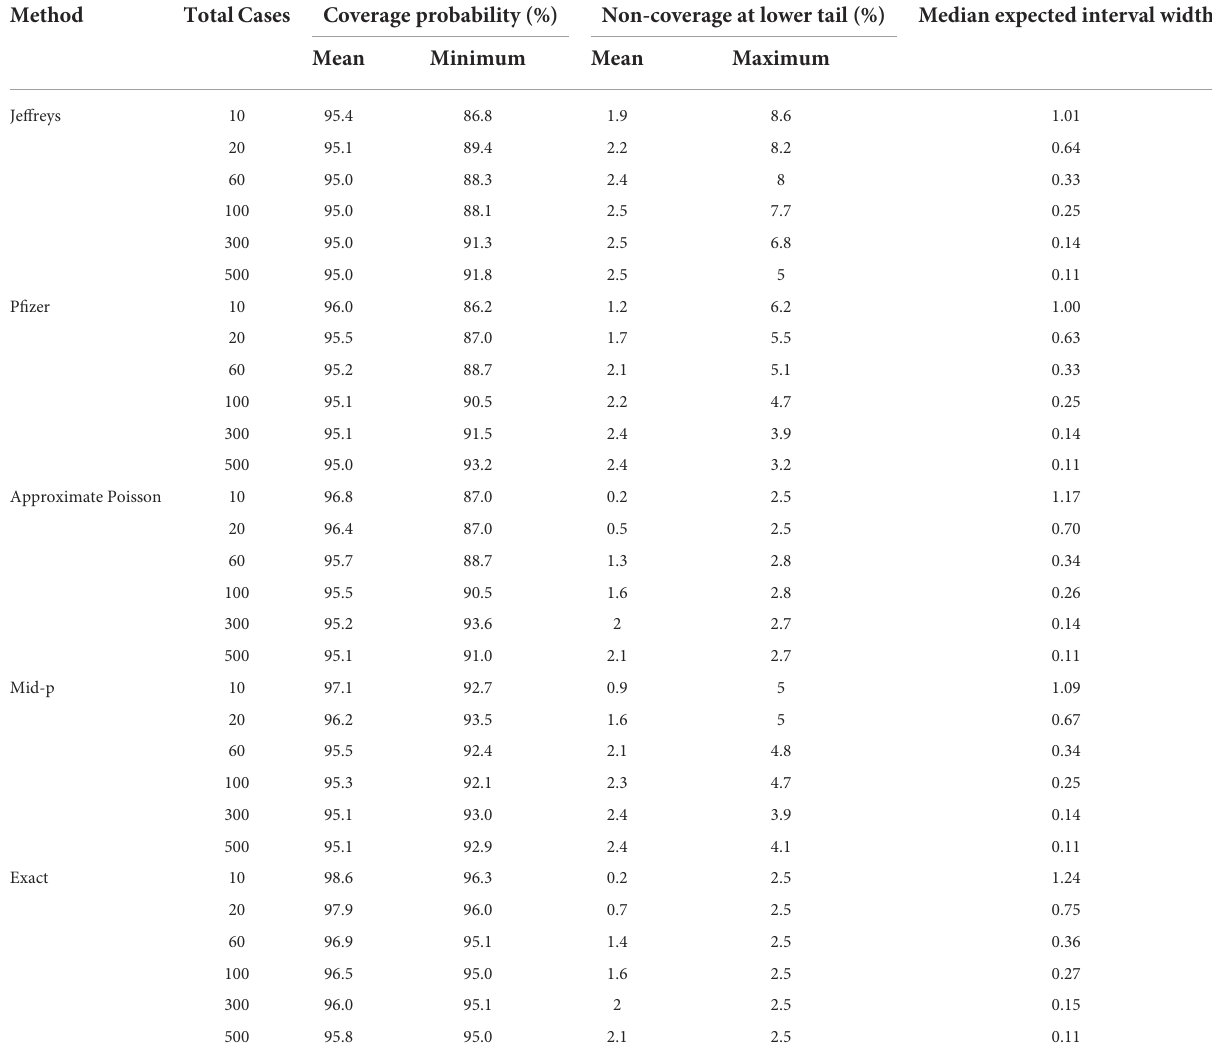
TABLE 1 Summary of coverage probability, non-coverage at lower tail, and expected interval